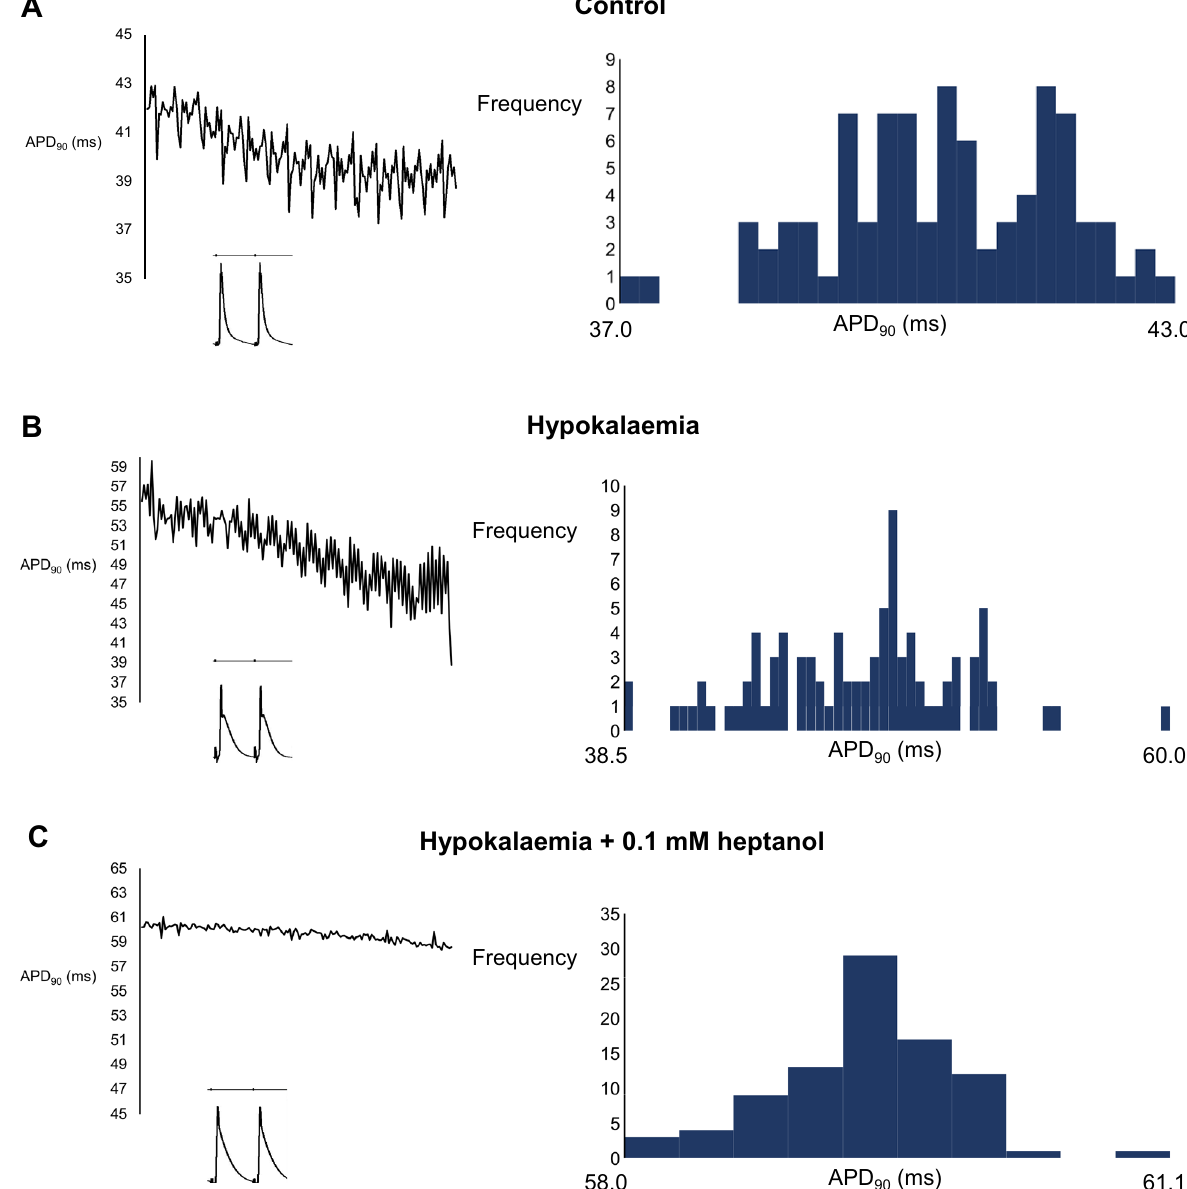
Fig. 1 MAP traces, time series and histograms of APDs from a representative heart before ( A ) or after the application of experimental hypokalaemia ( B ) and hypokalaemia with 0.1 mM heptanol ( C